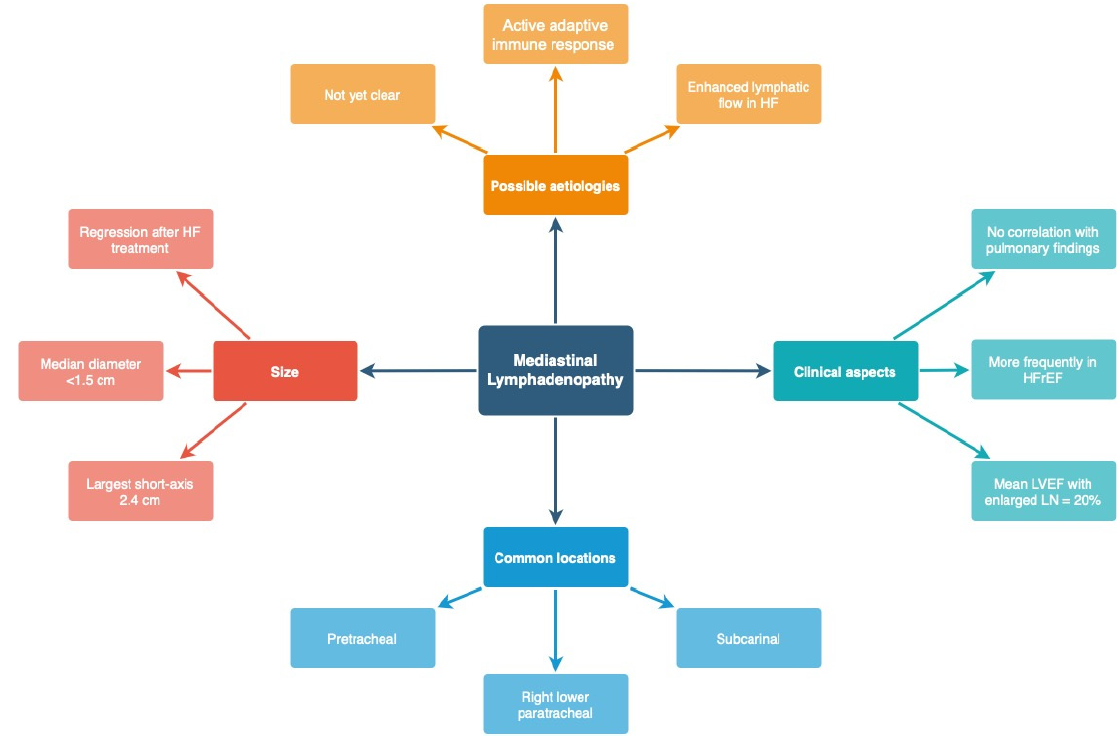
Figure 13. Characteristics of mediastinal lymphadenopathy related to heart failure. HFrEF—Heart failure with reduced ejection fraction; LN—lymph nodes; HF—heart failure.